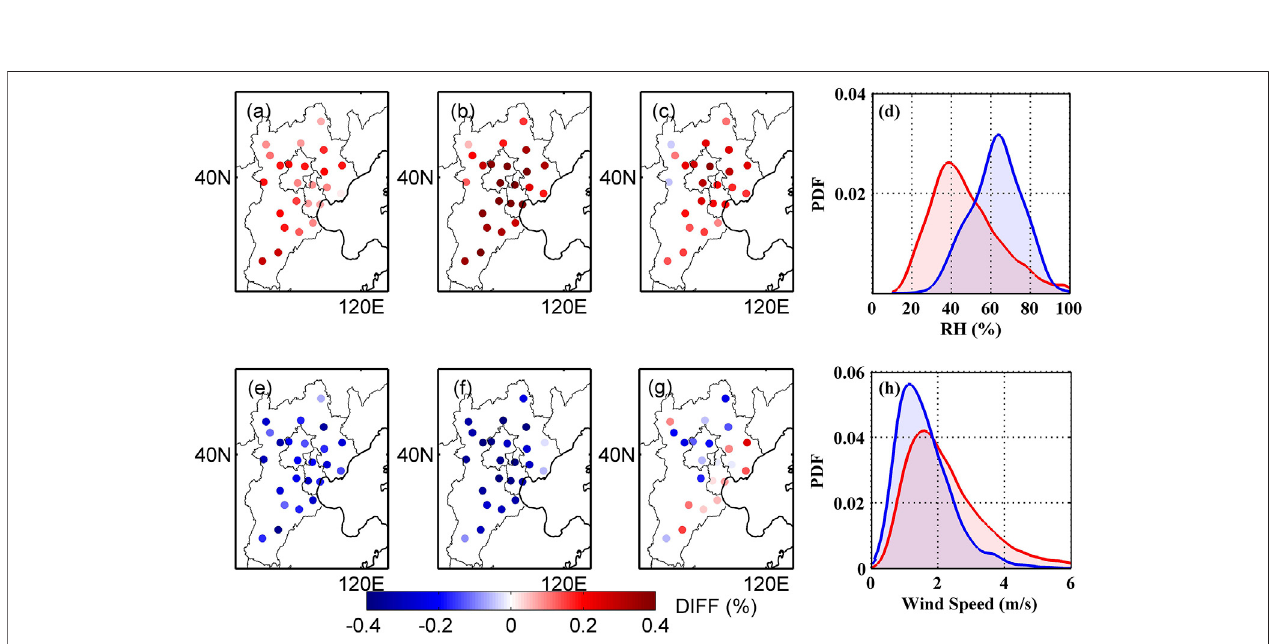
FIGURE3| FractionalchangesinRH (A – C) andinwindspeed (E – G) windspeed. (A,E) beforethelockdown; (B,F) atthebeginningofthelockdown; (C,G) during the lockdown. Panels (D) and (H) showthe probability density functions(PDFs)ofRH and wind speed, respectively. Blueand red shaded areas representthe beginning of the COVID-19 lockdown and the climatology,